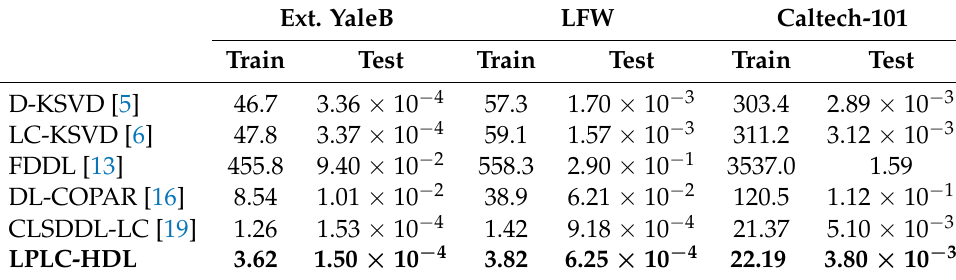
Table 7. The computational times (second) on the experimental